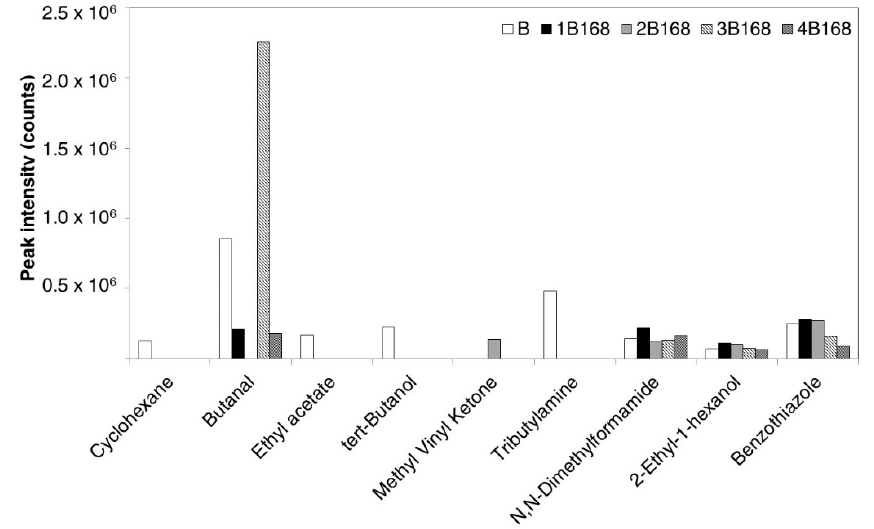
Figure 9. Relative intensity (counts) of 9 main compounds identified in samples B, 4B168, 1B168, 2B168 and 3B168 samples by HS-GCMS analysis.